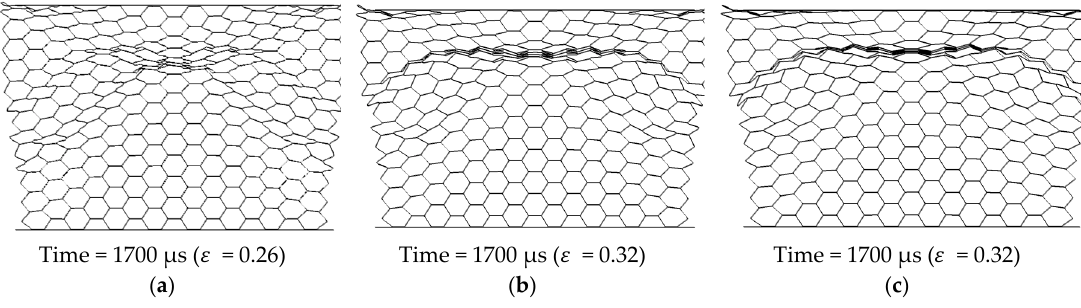
Figure 4. The deformation characteristics of three sizes of grids, (a) mesh size = 0.5 mm, (b) mesh size = 0.25 mm, and (c) mesh size = 0.125 mm.